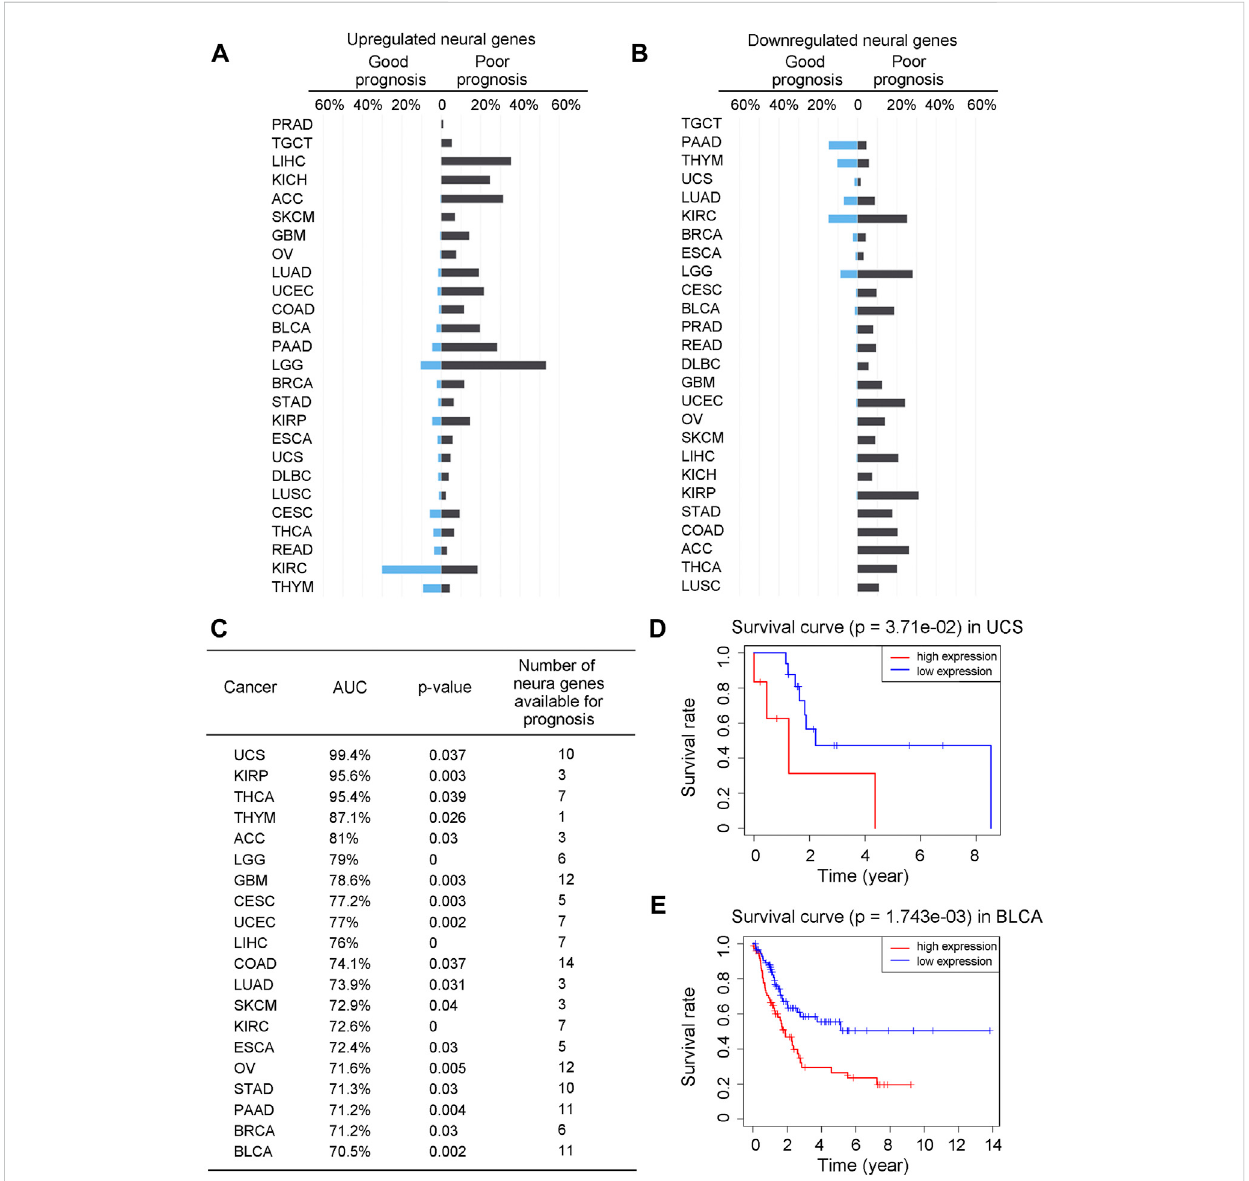
Theexpressionsofneuralgenescanpredictprognosis. (A,B) Bargraphsfortheproportionsofupregulated neuralgeneswith goodprognosis(HR < 1 and p -value < 0.05) or poor prognosis (HR > 1 and p -value < 0.05) across 26 cancer types (A) , and downregulated neural genes with good or poor prognosis (B) . Genesinblueare for good prognosis, while genesin black are for poor prognosis. (C) Predictionresult of theCox regression modelacross 20 cancer types, with AUC, p -value, and the number of selected prognostic neural marker genes. (D, E) Kaplan-Meier curves and the p -values for UCS and BLCA over the test sets of the Cox regression model, respectively. The x-axis is age in years and the y-axis is the survival rate. Gene expressions greater than the median is considered as high expressions, otherwise low